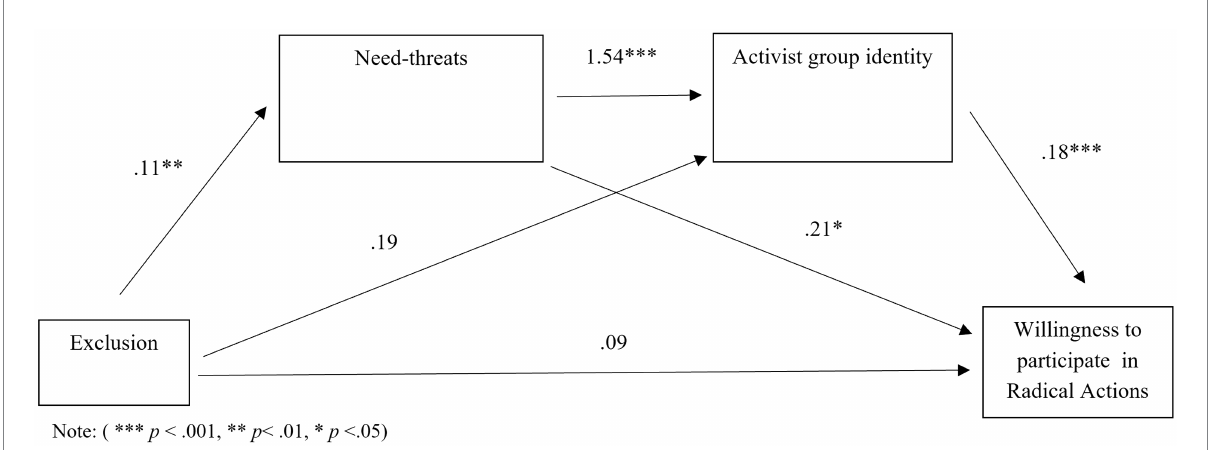
FIGURE 2 Serial mediation model with coefficients for pathway between exclusion and willingness to participate in radical actions with mediators need- threats and activist group identity.